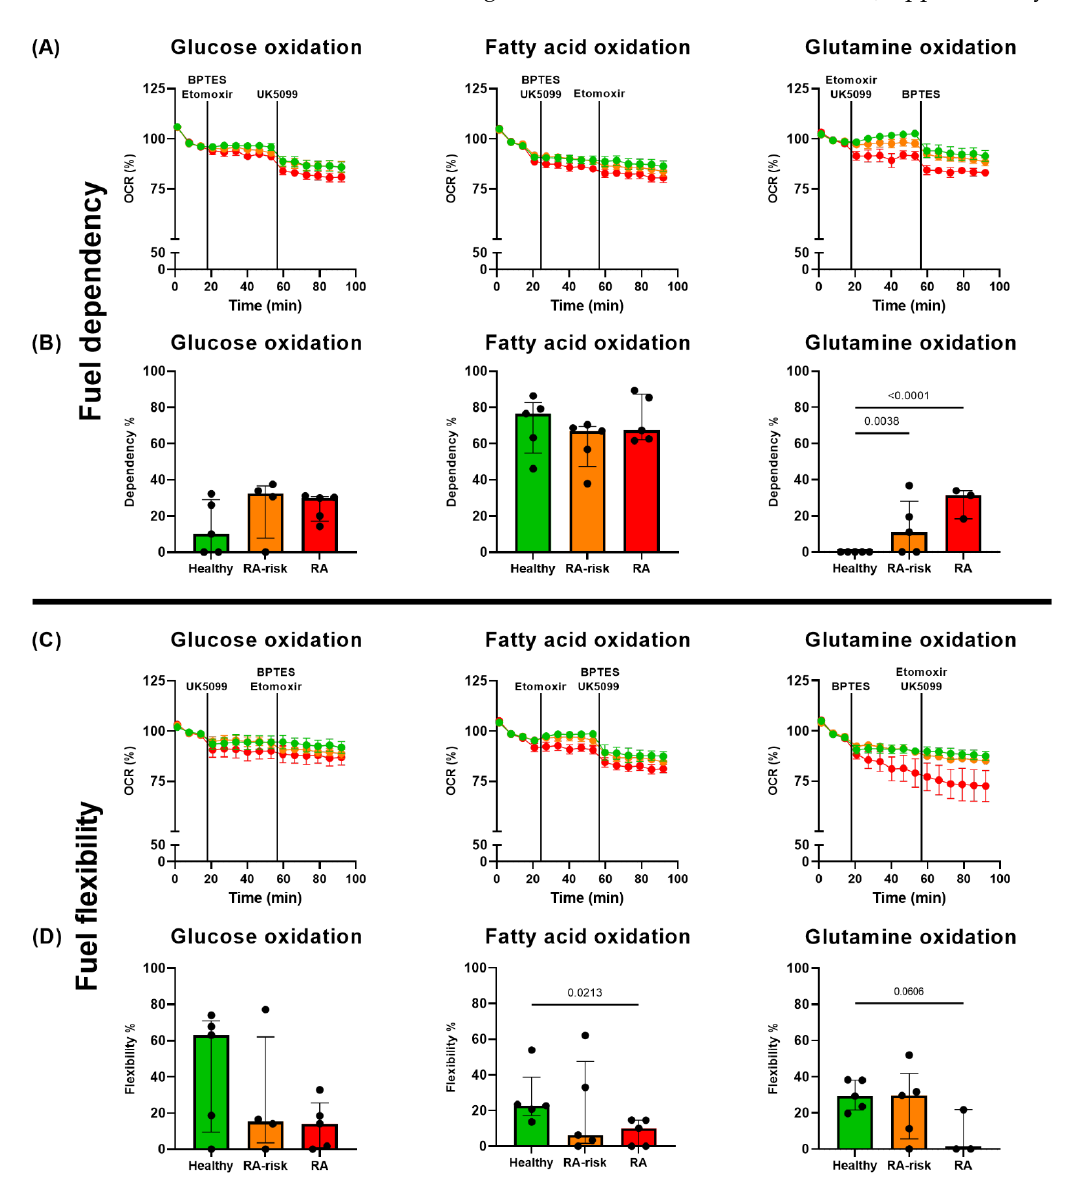
Figure 5. RA LNSCs are highly dependent on glutamine metabolism and not flexible to switch metabolic pathways compared with RA-risk and healthy LNSCs. ( A ) Real-time Seahorse measurement of the dependency of cultured LNSCs on glucose, fatty acids and glutamine. ( B ) Dependency of cultured LNSCs on metabolic pathways. ( C ) Real-time Seahorse measurement of the flexibility of cultured LNSCs on glucose, fatty acids and glutamine. ( D ) Flexibility of cultured LNSCs to use a metabolic pathway when the other two pathways are inhibited. All donors passage 5, unstimulated conditions. N = 5 for healthy and RA-risk, n = 3 for RA LNSCs and five technical replicates per condition, mean value of five replicates per donor is displayed. Data are presented as median + interquartile range. Statistical differences were determined using two-way ANOVA + Dunnett’s T3 multiple comparisons